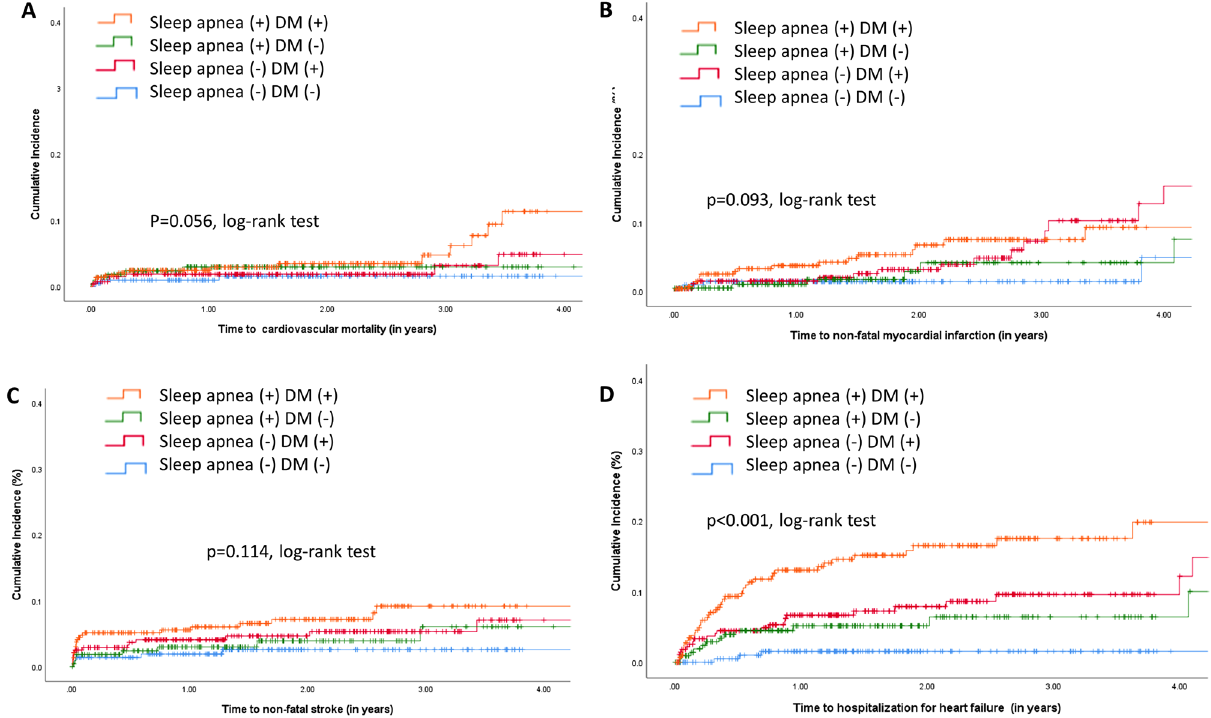
Figure 2. Kaplan–Meier analyses of the cumulative incidences of cardiovascular mortality ( A ), non-fatal myocardial infarction ( B ), non-fatal stroke ( C ), and hospitalization for heart failure ( D ).